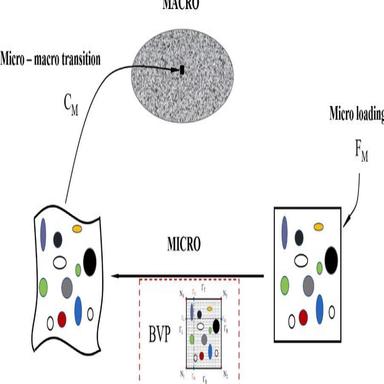
A schematic diagram of the homogenization method based on RVE implementation.